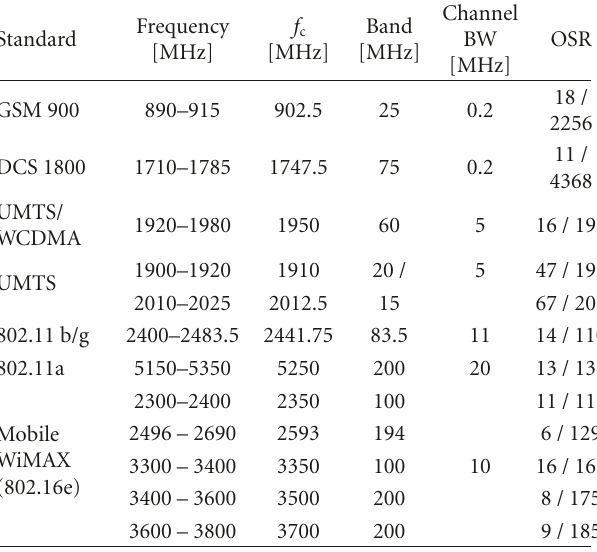
Figure 13: Signal spectrum of the polar ΣΔ architecture with digital mixing ( f ΣΔ = 3 . 7GHz). Table 2: Maximum possible oversampling ratio for the most di ff used mobile communication